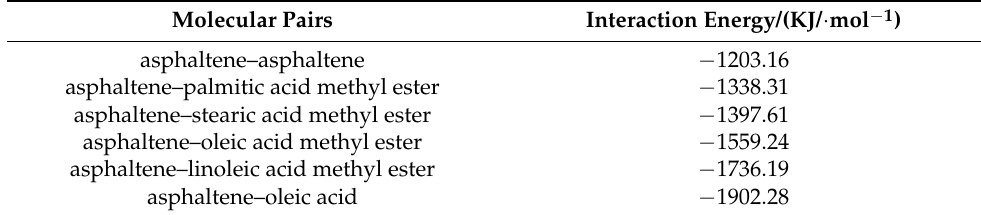
Table 8. Interaction energies of different pairs at 298